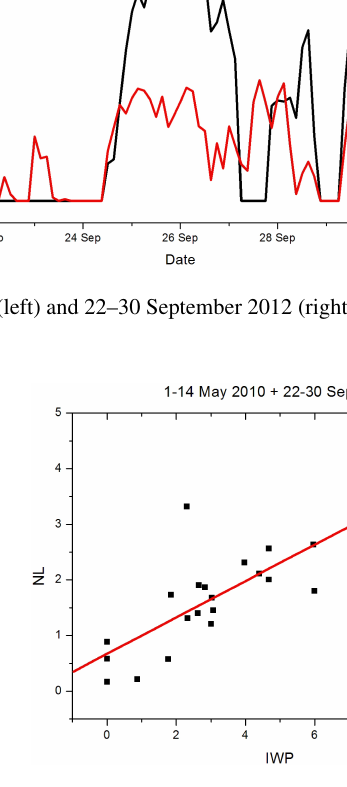
Figure 6. Linear correlation between IWPL and NL retrieved us- ing the ground-based measurements merging the datasets from both selected case studies: 1–15 May 2010 and 22–30 September